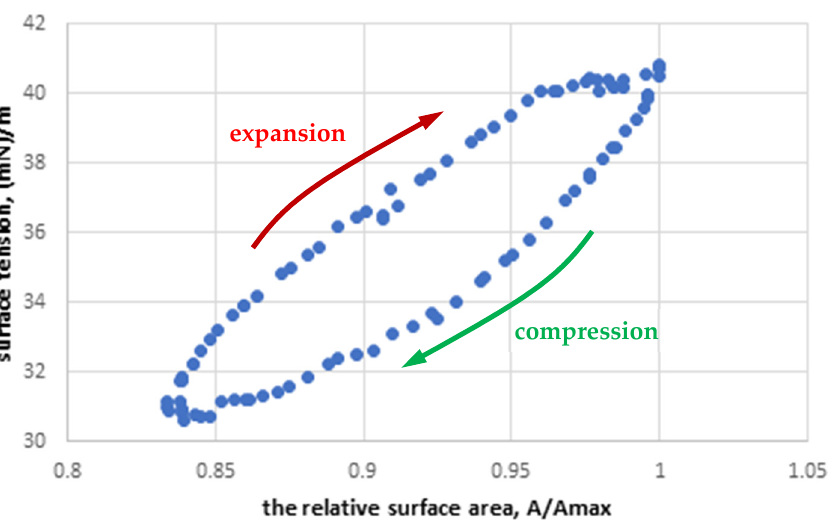
Figure 1. Exemplary surface tension hysteresis obtained experimentally for MPS (2.5 mg/mL) at f = 0.1 Hz.